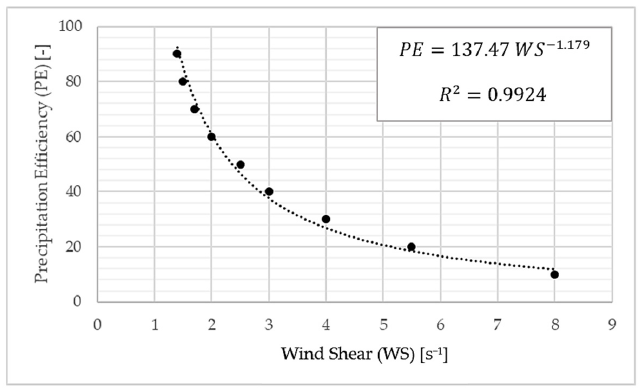
Figure 1. Relationship between precipitation efficiency and wind shear, modified by [99].